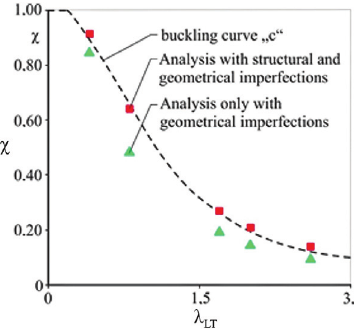
Fig. 15. comparison of numerical results with buckling curve “c”